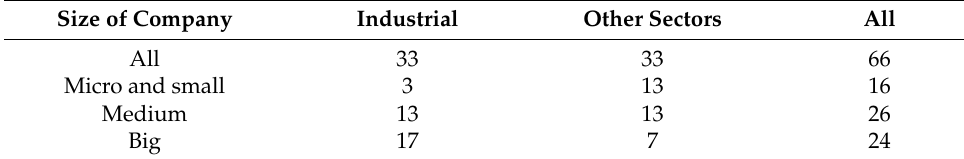
Table 4. Features of the research